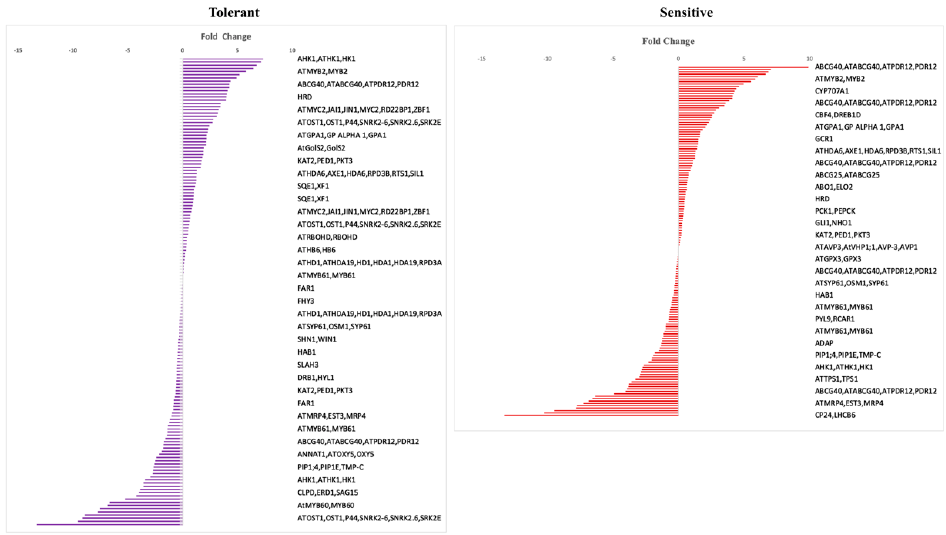
Figure 6. DEGs identified in the tolerant and sensitive genotype comparisons have the best hits to Arabidopsis genes in drought DB. DEGs are shown with fold changes.